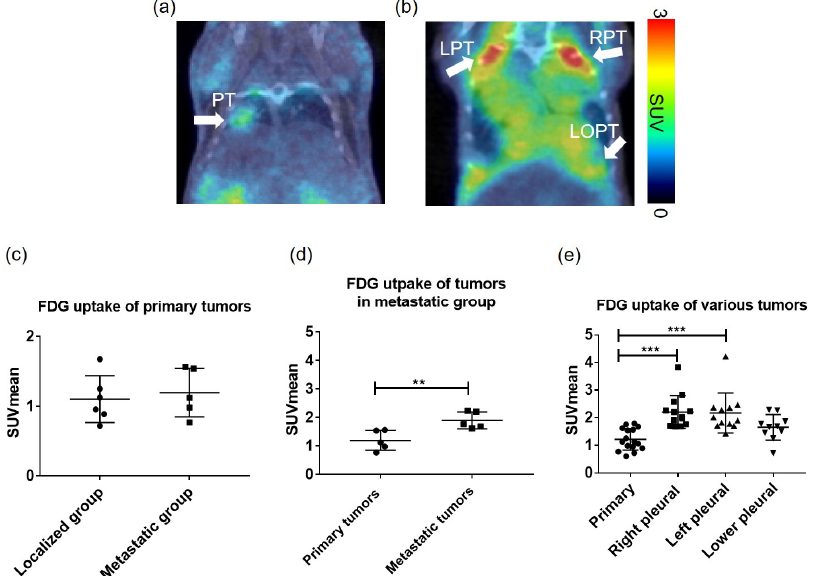
Figure 3. 18F-FDG uptake in primary lung tumors and metastatic tumors. ( a ) Representative coronal 18F-FDG PET/CT fused image showed one primary lung tumor (PT) growing in the left lung parenchyma in the localized group. ( b ) Representative coronal 18F-FDG PET/CT fused images of the metastatic group. In the left lung region, the left pleural tumor (LPT) was considered an invasion of the primary tumor. In the right lung region, the right pleural tumor (RPT) and lower pleural tumor (LOPT) were defined as metastases. ( c ) The 18F-FDG uptakes of primary lung tumors between localized and metastatic mice show no significant difference (localized group, SUV mean : 1.10 ± 0.34, N = 6, vs. metastatic group, SUV mean : 1.20 ± 0.35, N = 5, p > 0.79). ( d ) Tumor 18F-FDG uptake in metastatic mice, the metastases significantly elevated compared with primary tumors (primary tumors, SUV mean : 1.20 ± 0.35 vs. metastatic tumors, SUV mean : 1.97 ± 0.30 **, N = 5 for each group, ** p < 0.01. ( e ) Collected various lung tumors in studied mice, the significantly increased 18F-FDG uptake of tumors in the pleural was found (primary tumors, SUV mean : 1.21 ± 0.39, N = 16 vs. right pleural tumors, SUV mean : 2.21 ± 0.60 ***, N = 13, left pleural tumors, SUV mean : 2.17 ± 0.72 ***, N = 12, respectively ** p < 0.01, *** p <